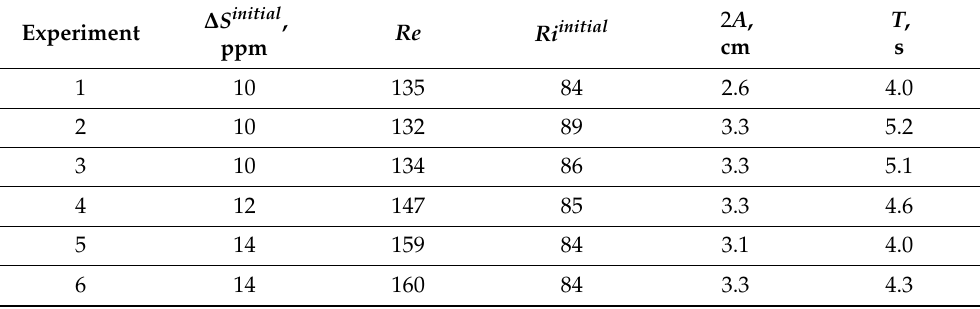
Table 1. The values of the defining dimensional and dimensionless parameters of the experiment: ∆ S initial , the initial value of the salinity difference between the layers; Re , the Reynolds number; Ri initial , the initial value of the Richardson number; 2 A , double amplitude of the rods oscillation; T , the period of the oscillations of the